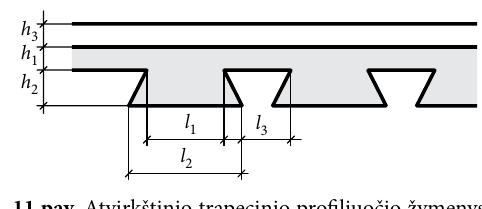
Fig. 10. Symbols of a trapezoidal profiled sheet